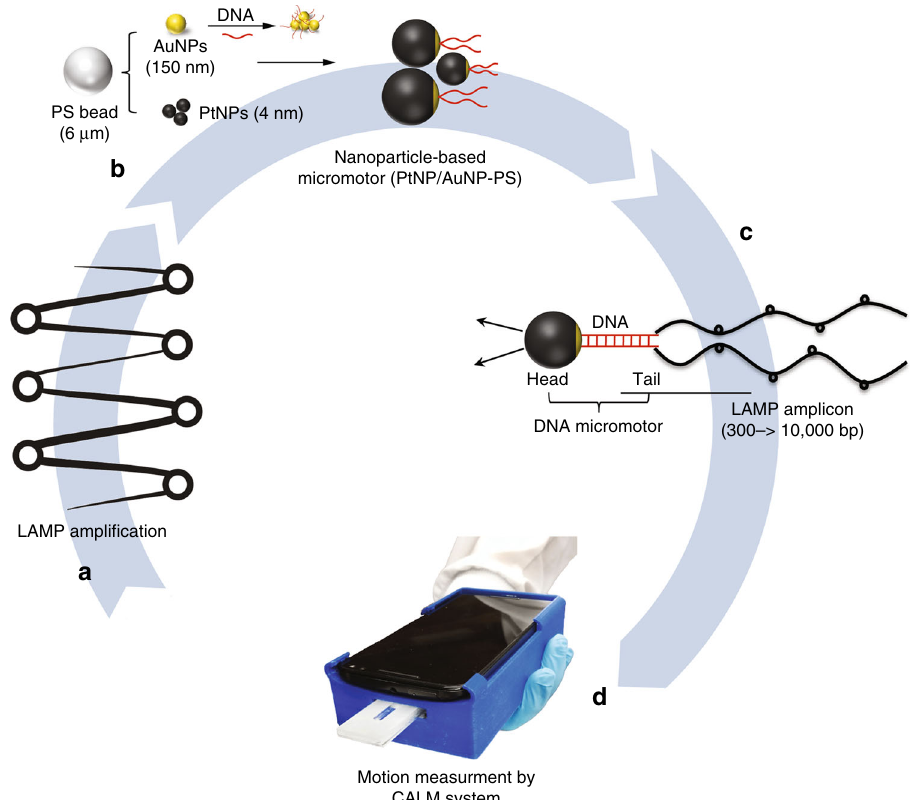
Fig. 1 Schematic presentation of HIV-1 detection using the cellphone system. The developed system integrates cellphone-based optical sensing, loop- mediated isothermal ampli fi cation and micromotor motion (CALM). a A loop-mediated isothermal ampli fi cation (LAMP) reaction is performed to amplify the nucleic acid of HIV-1 and large-size looped amplicons. b The formed amplicons are mixed with DNA-modi fi ed micromotors that are speci fi cally designed using 6- μ m polystyrene (PS) beads covered with a hybrid surface layer of platinum (Pt) and gold (Au) nanoparticles to power the catalytic motion of motors in the presence of hydrogen peroxide. c The capture of LAMP amplicons on the surface of motors results in the formation of motile assemblies with a catalytic head of motors and large tail of DNA. d The motion of these assemblies can be detected and measured using a